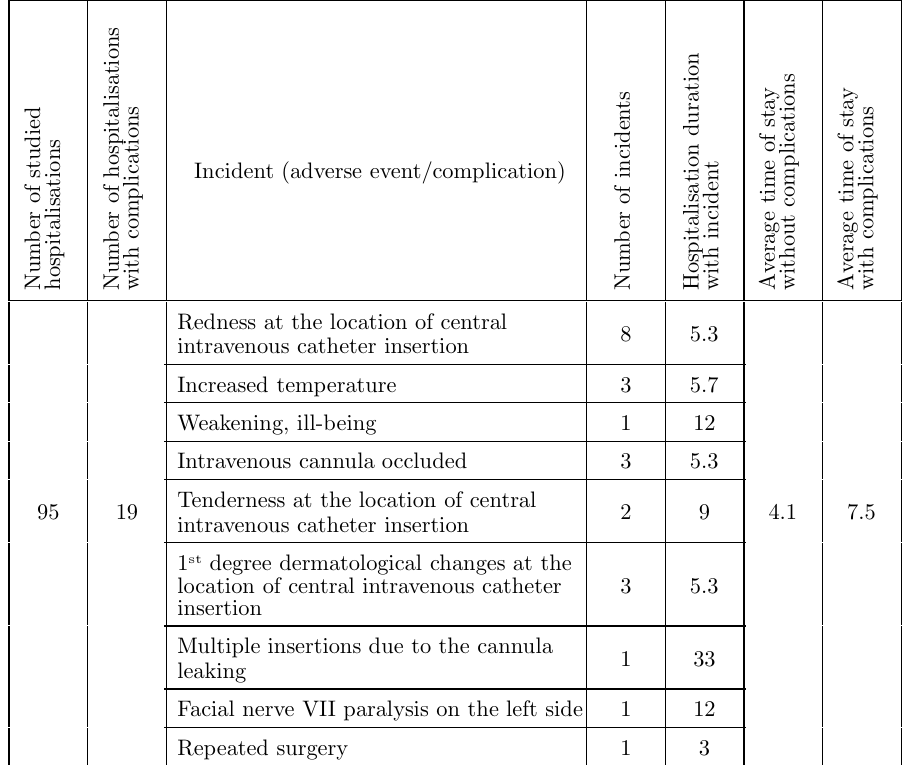
Table 1. Adverse events identified during the analysis of the C22 group in the Face and Jaw Surgery